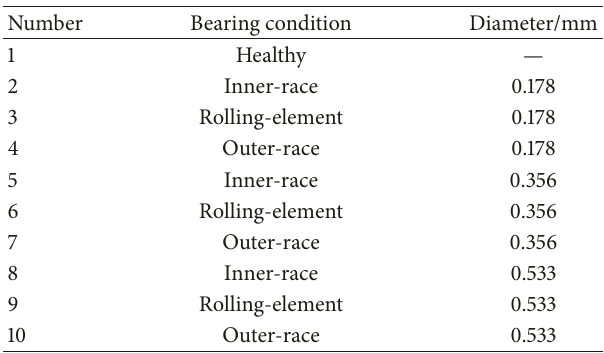
Figure 4: Typical waveforms from the four conditions. Table 3: Bearing fault